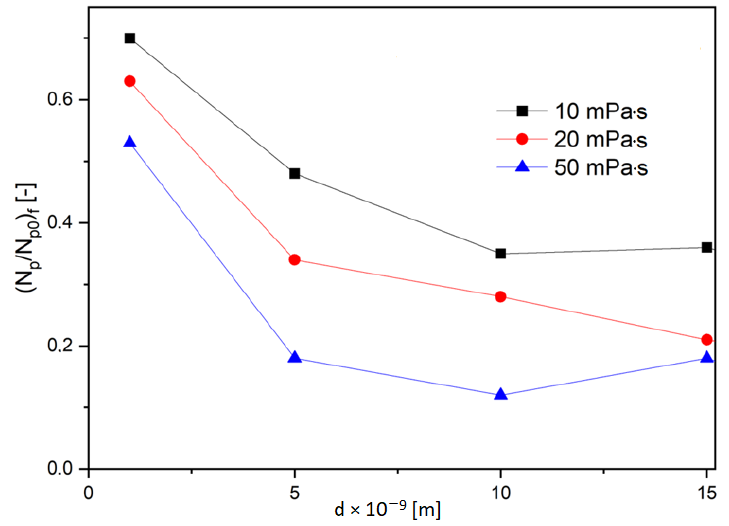
Figure 7. The dependence of the number of particles as a function of their diameter for liquids of different viscosities. Table 1. Values of the effective diffusion coefficient, D eff , and the n